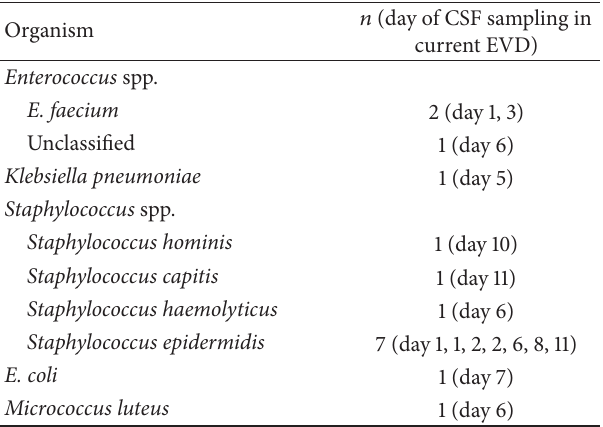
𝑛 (day of CSF sampling in current EVD)